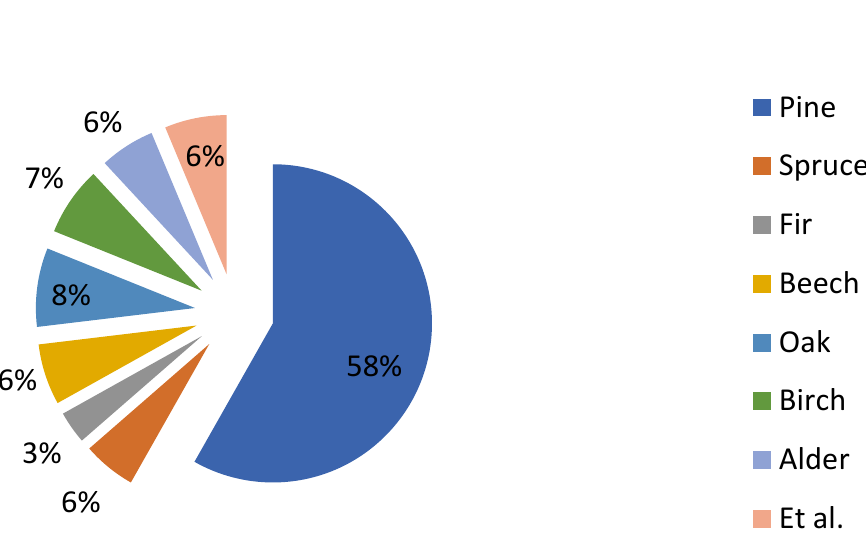
Figure 2. The area share (%) of the dominant tree species in the state-owned and private forests (Large Scale Forest Inventory 2016 – 2020 [32]).